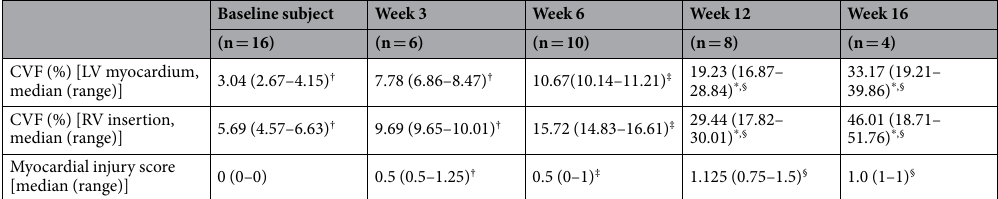
Table 3. Histologic data of all subjects. * Indicated p < 0.05. † Indicated n = 3, ‡ indicated n = 2, § indicated n =